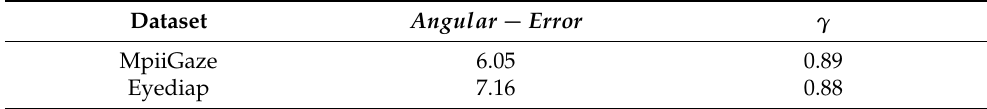
Table 6. The performance of DRNet_NoAD. Dataset Angular −